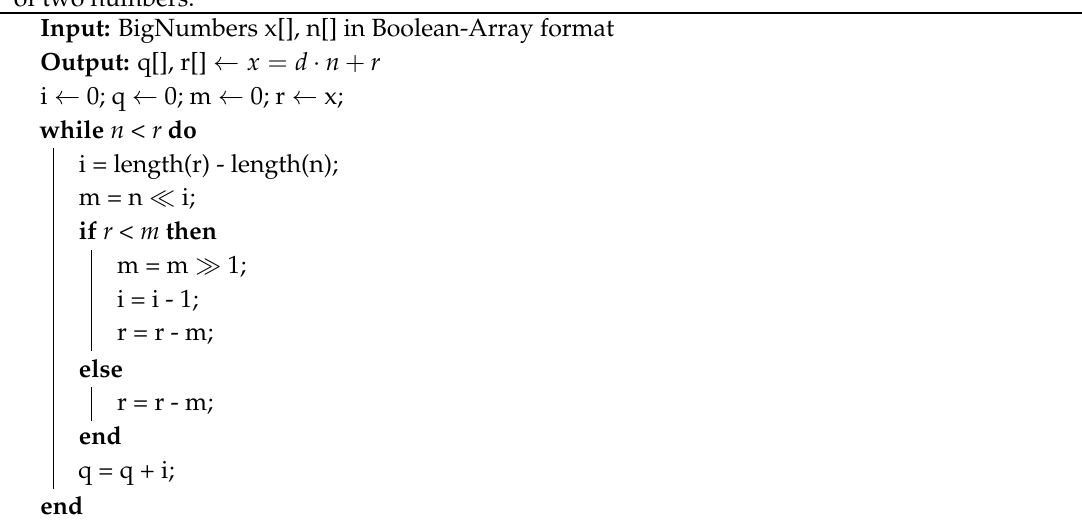
Algorithm 1: Pseudo Code of the ’Quotient and Remainder’ algorithm to calculate the modulo of two